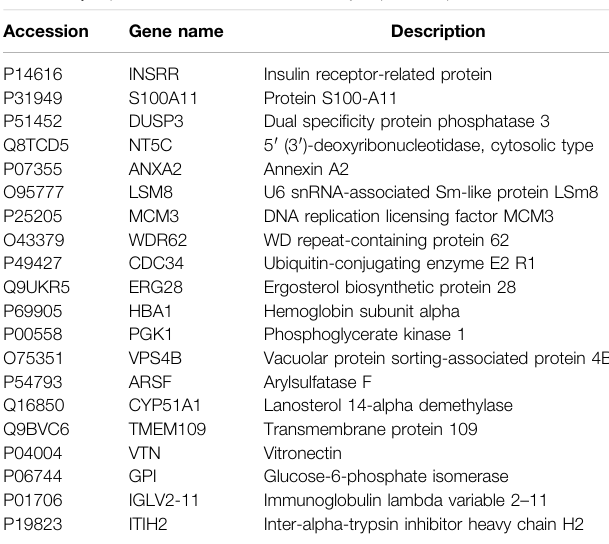
TABLE 1 | Top 20 of the common differentially expressed